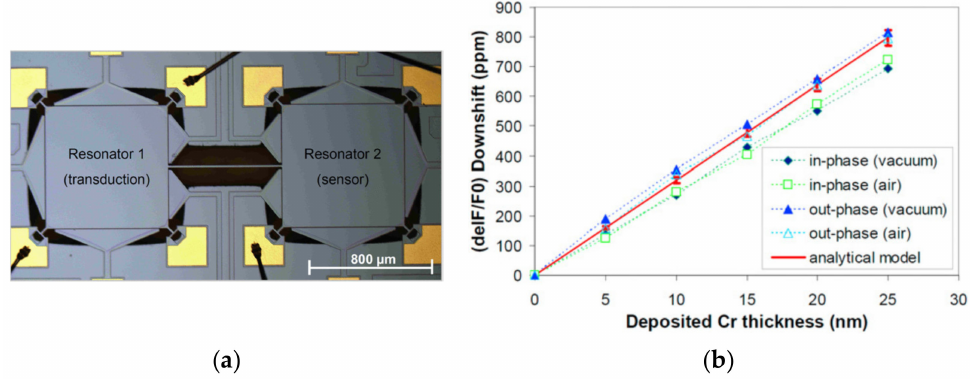
Figure 25. ( a ) Optical micrograph of the 2-DoF BAW resonator system; ( b ) Comparison between the analytical frequency shift and the measured one with respect to the deposited Cr film thickness. Reprinted with permission from Ref.